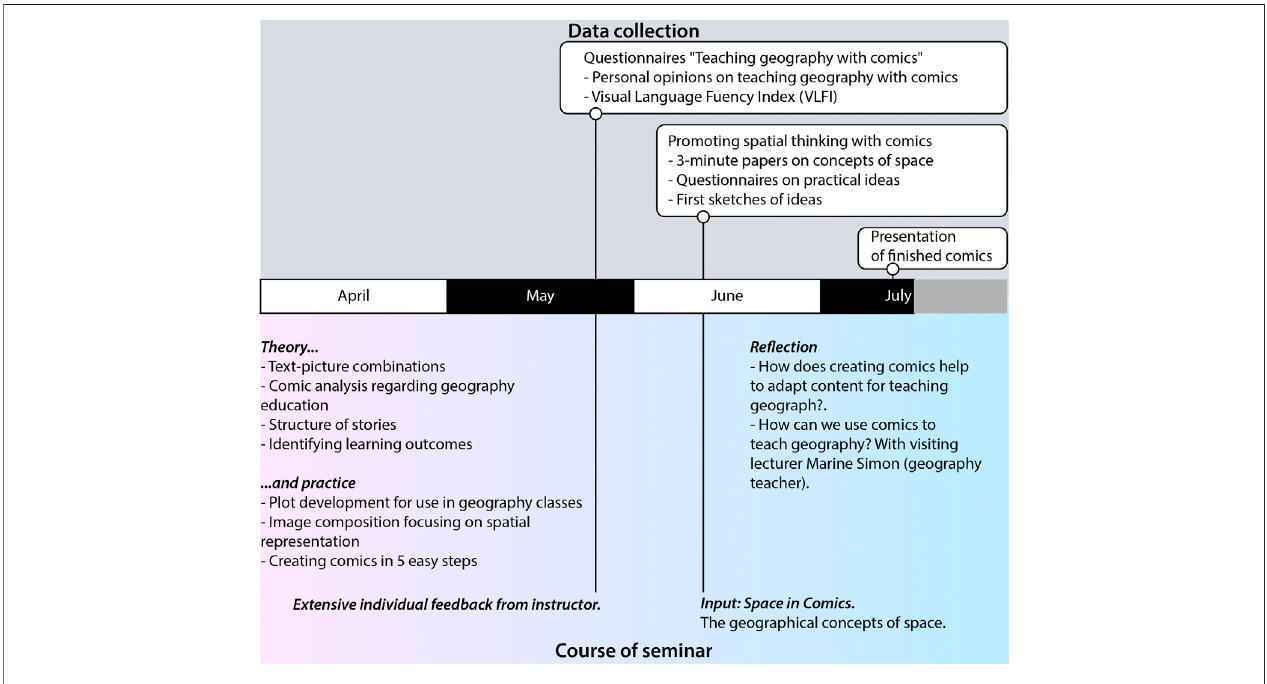
FIGURE 1 | Timeline of the course of the seminar and data collection for this